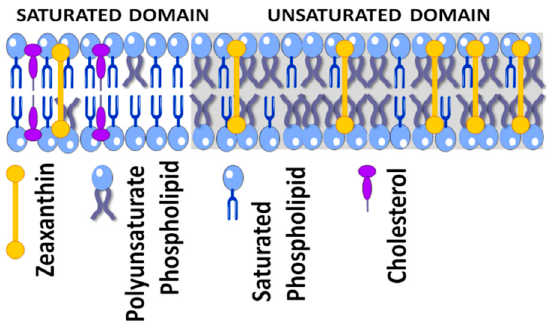
Figure 5. Schematic drawing showing the colocalization of zeaxanthin together with polyunsaturated phospholipid in the membrane domain. For more details, see Refs. [33,71,72].